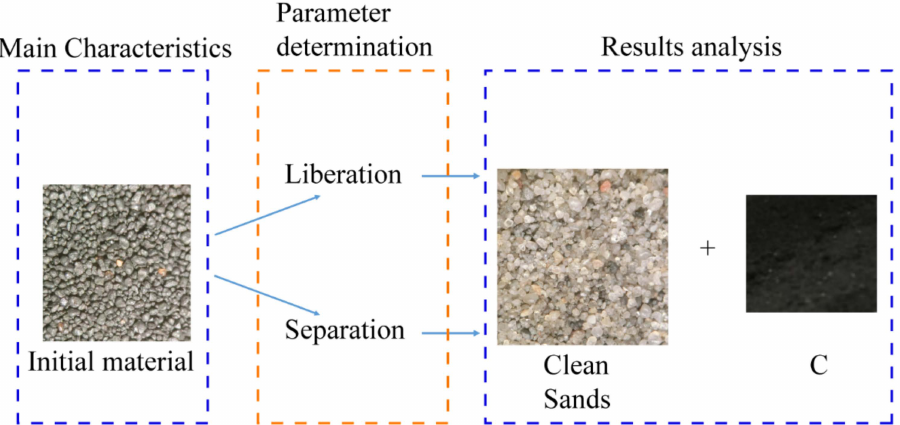
Figure 1. Work strategy scheme to evaluate liberation performance. In an initial stage we have raw material. After liberation and separation, the obtained material is a clean sand plus the removed volatile matter, which is mainly